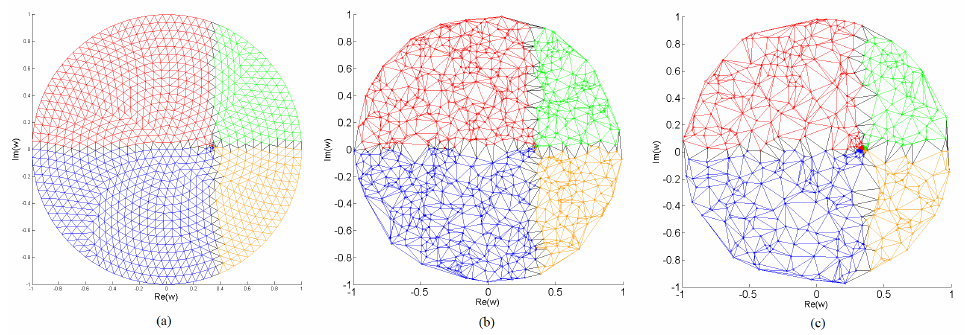
Figure 7. Distribution of nodes with Delaunay’s triangulation in final iteration for ( a ) the GRPF, ( b ) MGA-WPA, and ( c ) MPSO-WPA methods. The stability tests of a fractional-order digital filter are executed in the transformed region | w | < 1. Phase quadrants of mesh nodes on the w -plane: •Q =